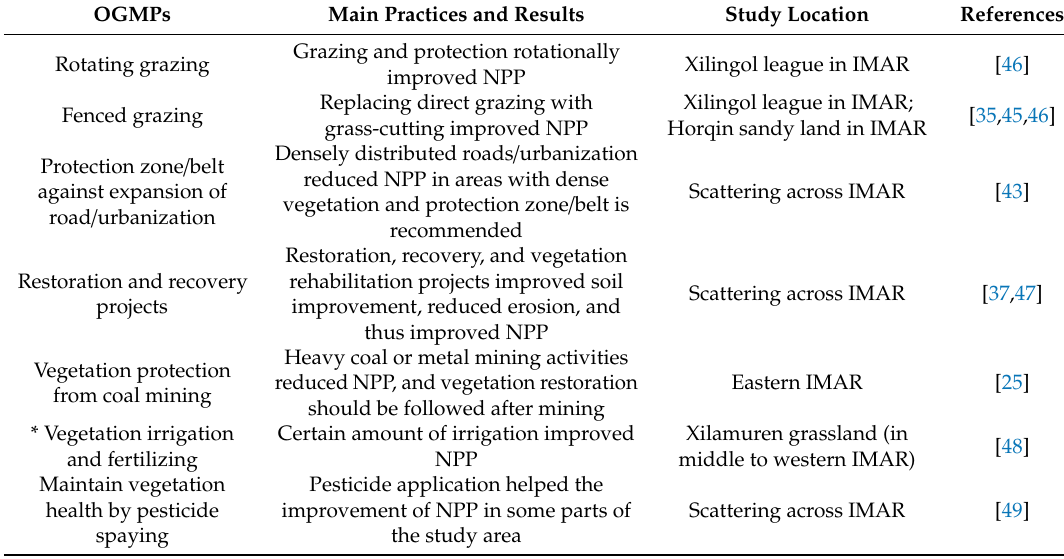
Table 5. Typical examples of optimal grassland management practices (OGMPs) in Inner Mongolia.